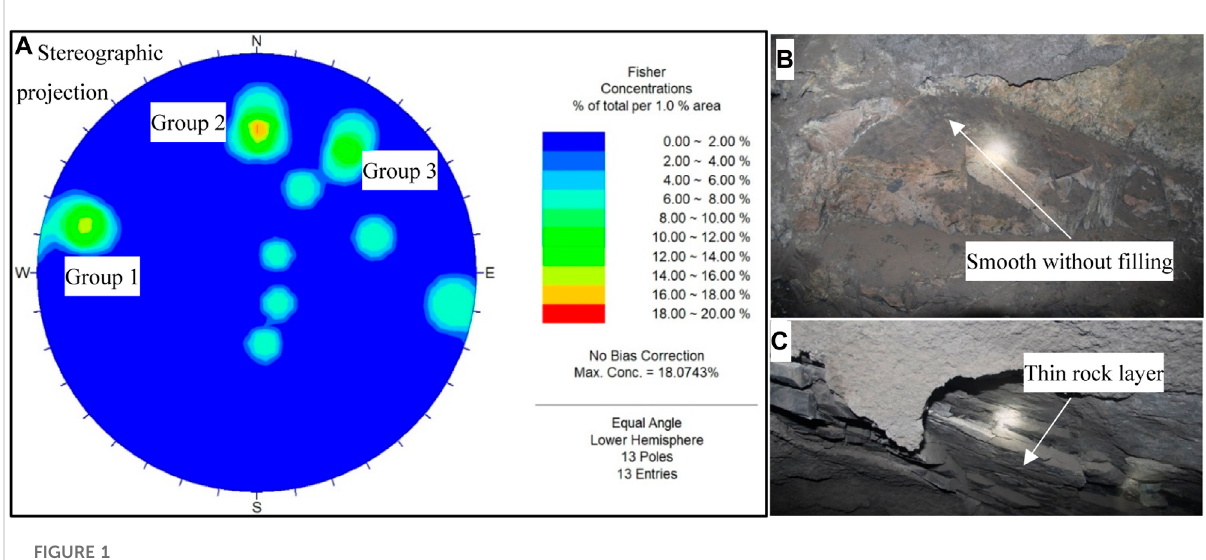
FIGURE 1 Stereographic projection and observed characteristics for the discontinuities in the hanging wall. (A) Stereographic projection. (B) Group 1. (C) Group